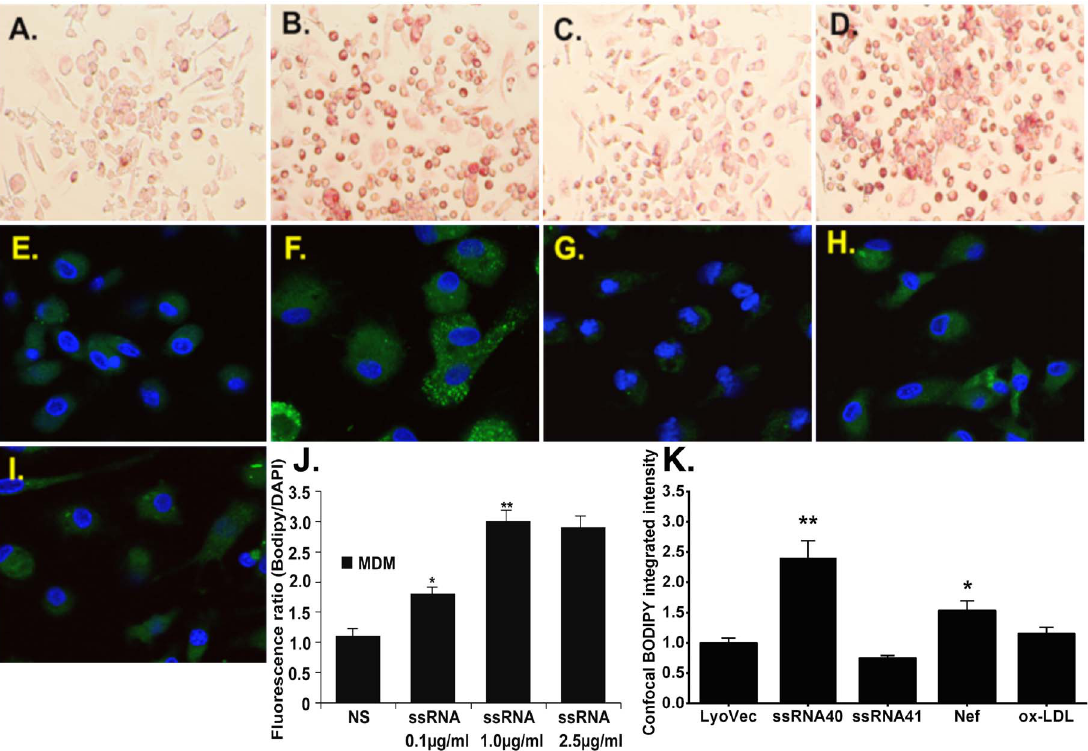
Figure 2. HIV-derived ssRNA induces foam cell formation in a dose-dependent manner. MDMs were stimulated with different stimulants for 24 h and stained with either Oil Red O staining ( A–D ) or BODIPY staining ( E–J ), and the bar graph shows integrated fluorescence intensities for BODIPY in each cell of the confocal micrographs (K). The fluorescence intensity ratio (BODIPY/DAPI) from microplate assays shows the concentration dependence of ssRNA-stimulated lipid accumulation (BODIPY) normalized to the number of cells (DAPI) in J . Data shown is a representative experiment with similar results from four different healthy uninfected subjects. *p , 0.01, **p , 0.01 compared to vehicle control (LyoVec; NS). ssRNA control (ssRNA 41) HIV-ssRNA (ssRNA